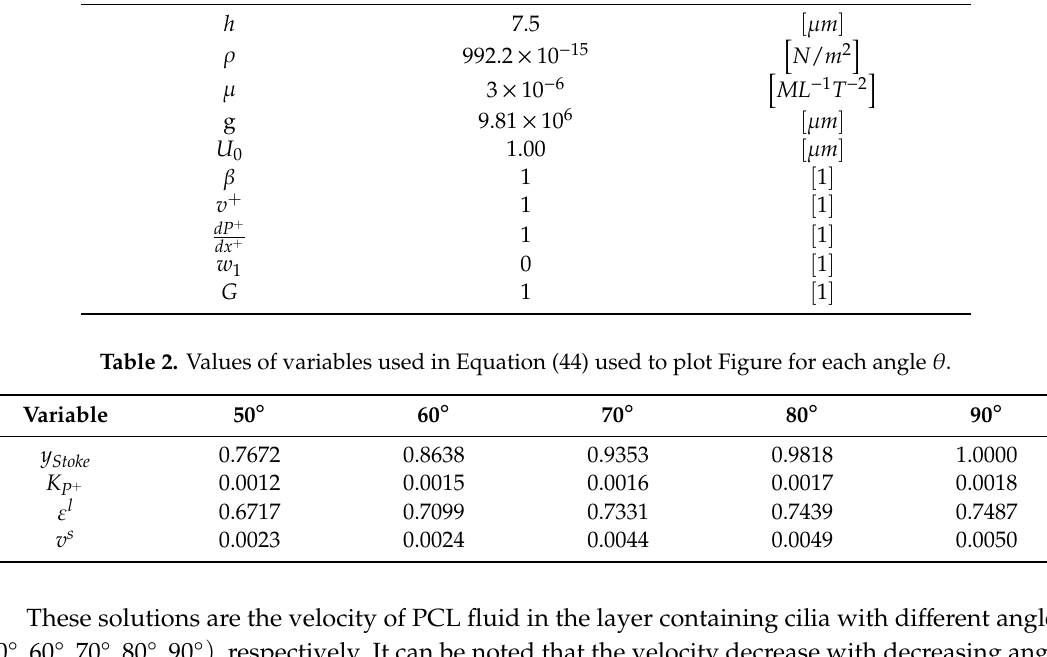
Table 1. Variable of the experimental data in the solution of the Stoke–Brinkman equations.